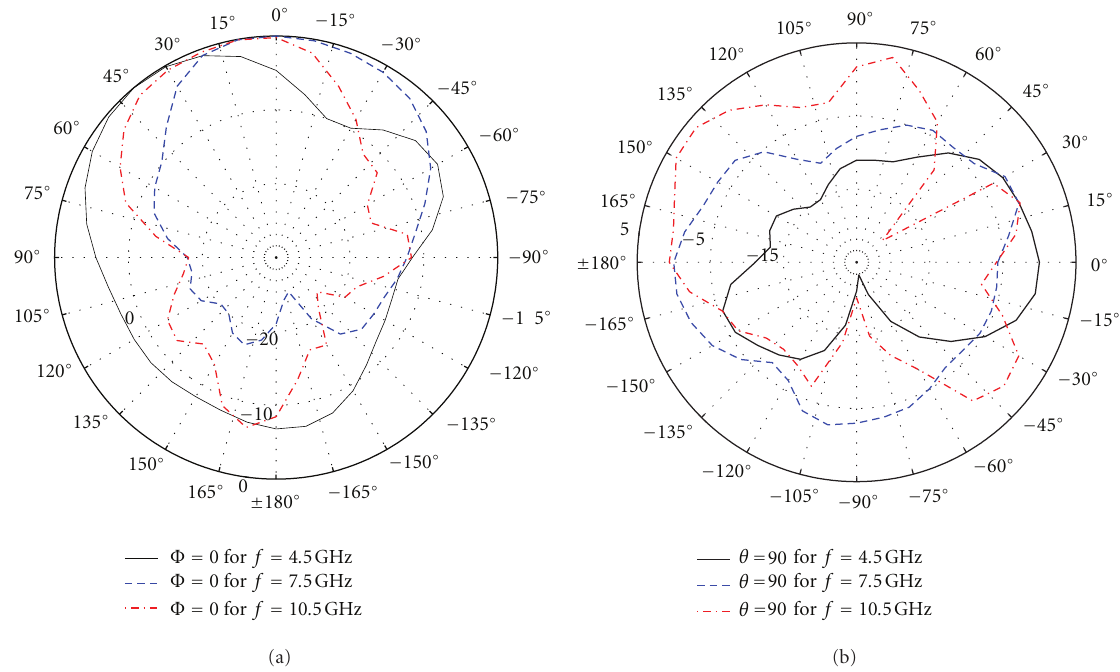
Figure 7: (a) 2D rad. pattern with total gain in dB for elevation XZ plane ( Φ = 0 ◦ ) for di ff . frequencies, (b) 2D rad. pattern with total gain in dB for azimuth XY plane ( θ = 90 ◦ ) for di ff erent frequencies.